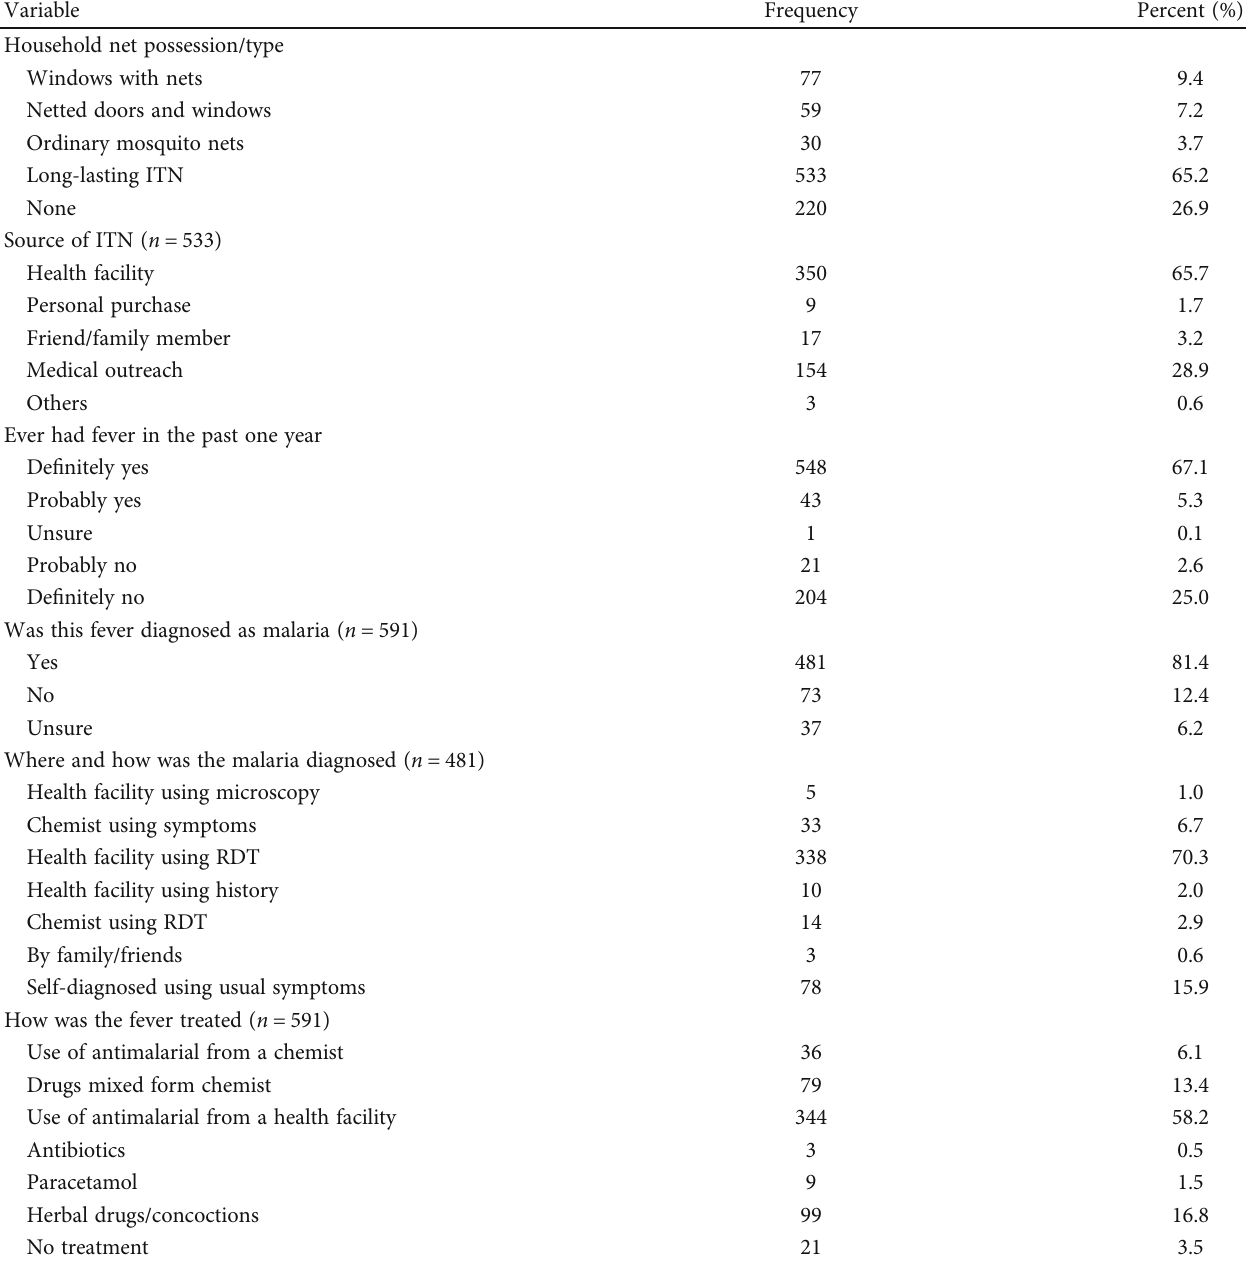
Table 2: Malaria-related characteristics of community members in Ebonyi, Nigeria ( n = 817